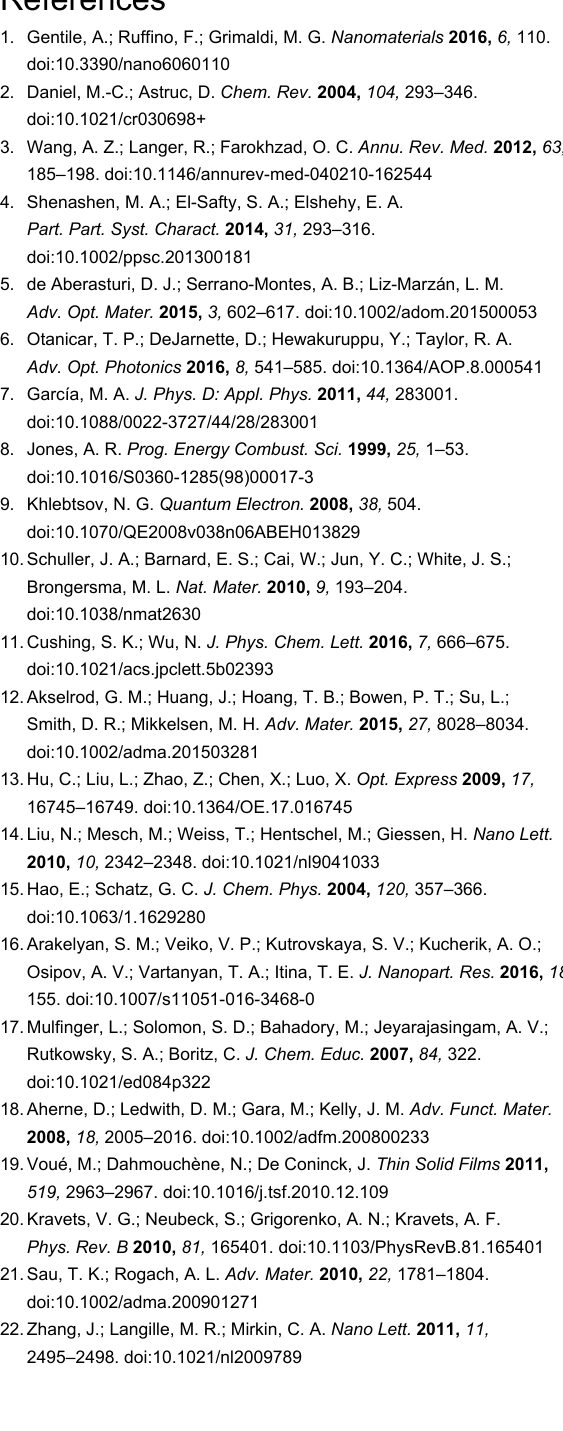
Figure 4: AFM topography of the nanospheres on a substrate.